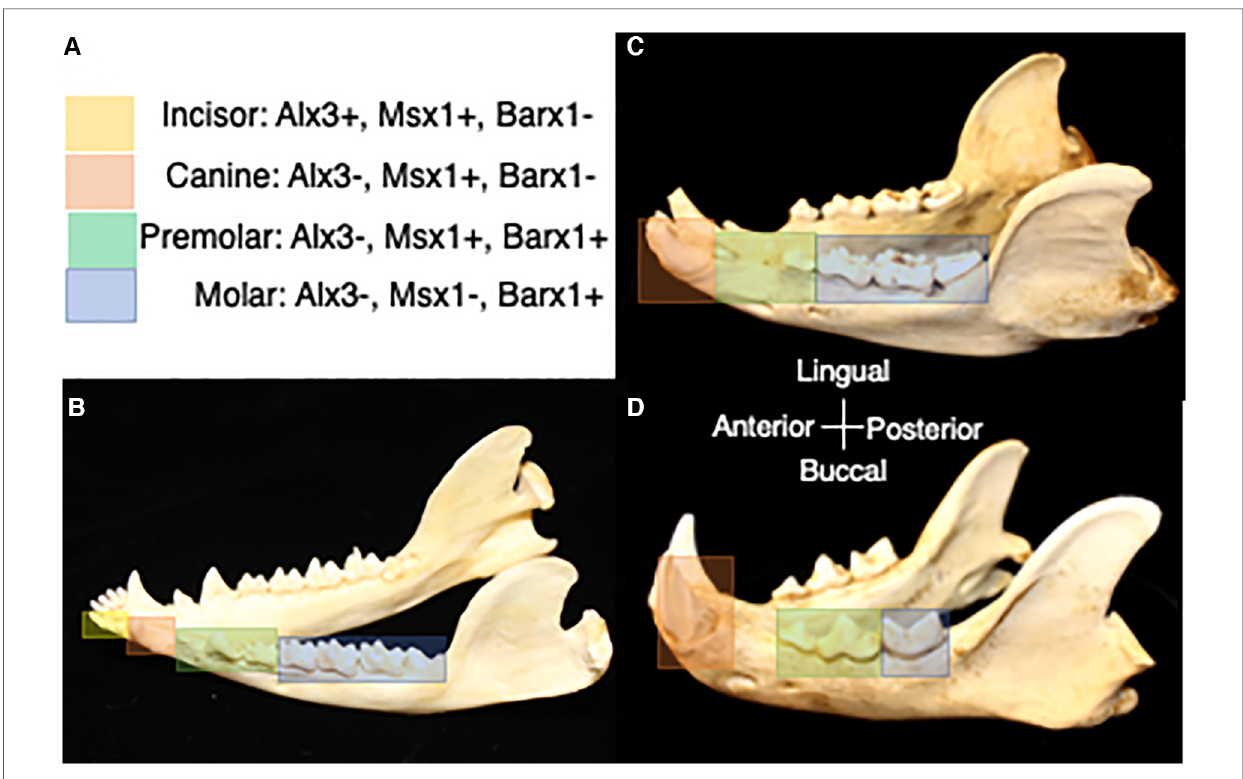
FIGURE 3 ( A ) Homeobox code expression in association with tooth classes in the prototypical mammal jaw (50). Yellow corresponds with expression of homeobox genes in the incisor region, orange corresponds with expression of homeobox genes in the canine region, green corresponds with expression of homeobox genes in the premolar region, and blue corresponds with expression of homeobox genes in the molar region. ( B ) Homeobox gene expression in association with tooth classes in the jaw of the opossum, Didelphis . ( C ) Predicted homeobox gene expression patterns in association with tooth classes in the jaw of the bear, Ursus . ( D ) Predicted homeobox gene expression patterns in association with tooth classes in the jaw of the cat, Felis . Differences in the range of expression of combinations of homeobox genes is expected to correspond with evolutionary changes in tooth class number. Dentitions are not shown to